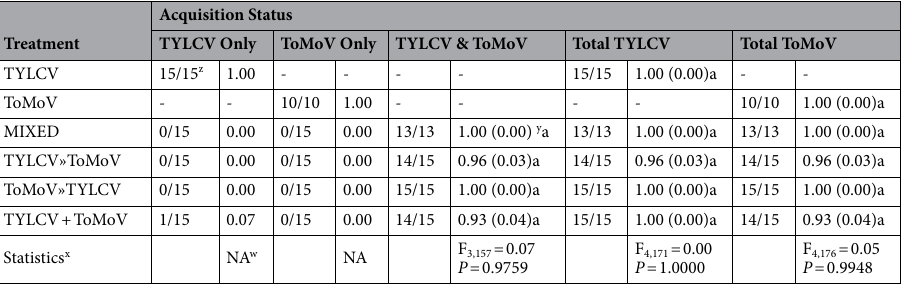
Table 2. The average proportion of whitefly cohorts that acquired TYLCV or/and ToMoV. LS means comparisons among treatments were conducted using Tukey’s method at P = 0.05 level to compare acquisition of viruses singly (TYLCV only, ToMoV only columns), together (TYLCV & ToMoV column), and sum of virus infection (Total TYLCV, Total ToMoV columns). z Total number of samples testing positive/total number tested. y Mean (Standard Error). x F Value, Num DF, Den DF, Pr > F. w Statistical comparison could not be performed, raw means presented from Excel. - No